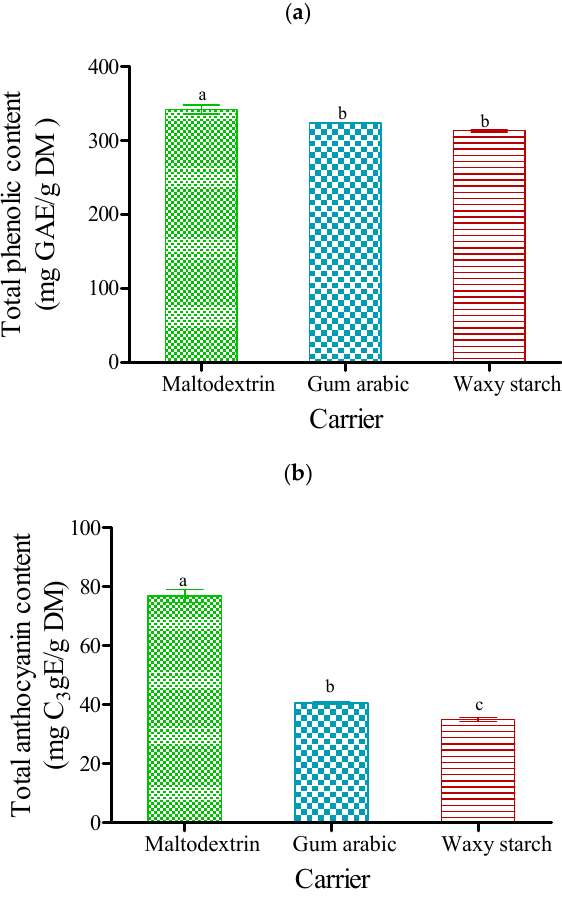
Figure 4. Total phenolic content ( a ) and total anthocyanin content ( b ) of freeze-dried pomegranate powder using di ff erent carriers. Bars with di ff erent letters are significantly di ff erent ( p < 0.05) according powder using different carriers. to Fisher’s LSD. Vertical bars indicate the standard error of the